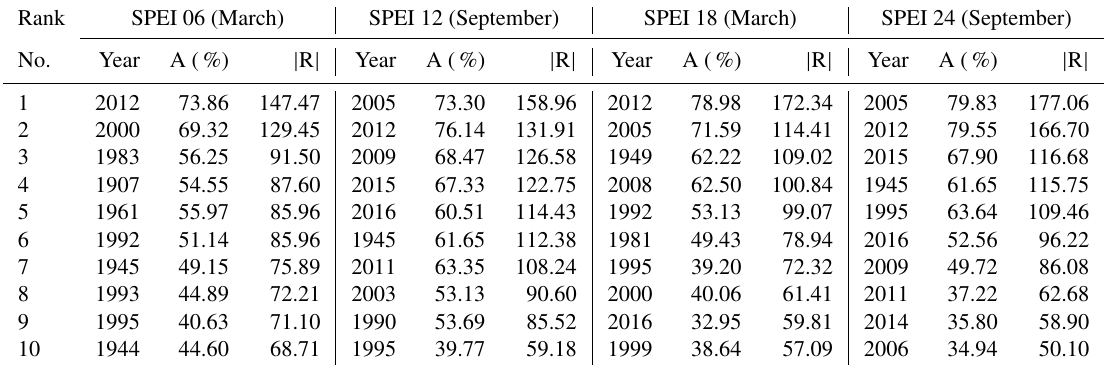
Table 1. The 10 most dry extreme events (top 10) for each timescale. Absolute final rank index, | R | , for the 6-month timescale obtained for March (SPEI 06), for the 12-month timescale obtained for September (SPEI 12), for the 18-month timescale obtained for March (SPEI 18), and for the 24-month timescale obtained for September (SPEI 24). “A” represents the area (in percent) where the respective index is below the − 1 . 28